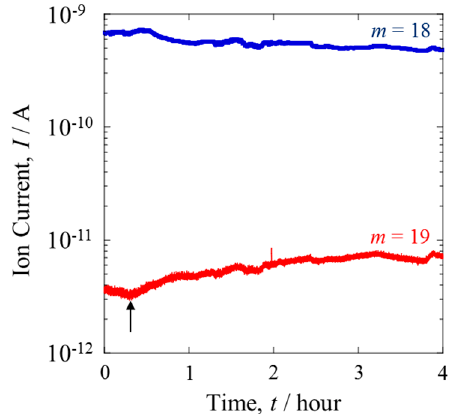
Figure 3. Transient behavior of Q-Mass spectra of mass numbers m = 18 (H 2 O, blue line) and 19 (HDO, red line) at the cathode side. Arrow indicates the onset time, when the mixture of H 2 (10.0 mL·min − 1 ) and D 2 (0.1 mL·min − 1 ) was passed to the anode side.